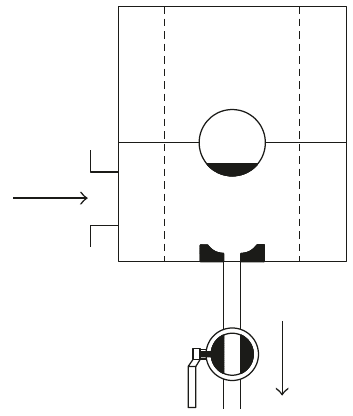
Figure 1: Schematic diagram of drainage